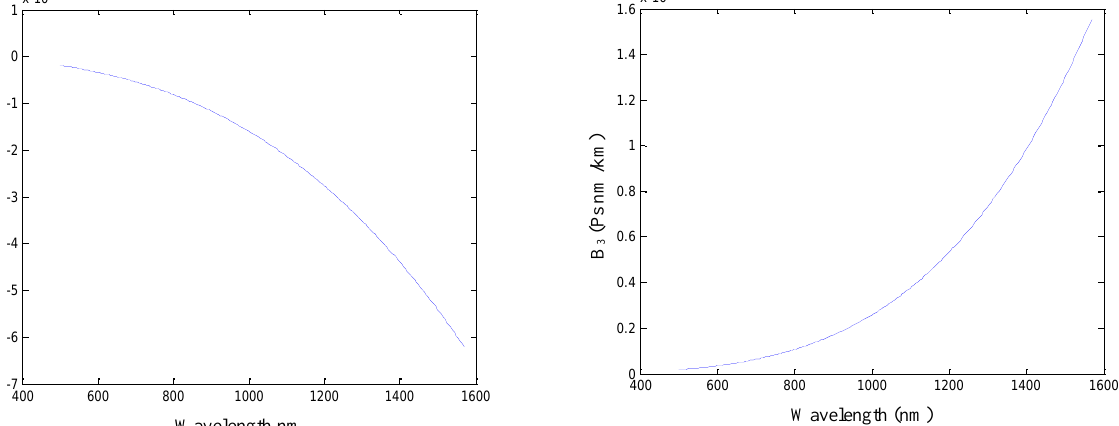
Figure 4. Third-order dispersion B 3 2